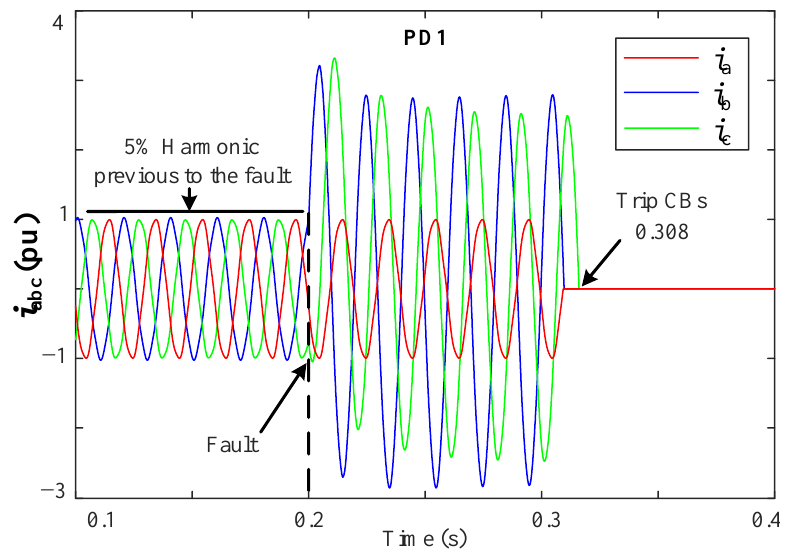
Figure 12. i abc currents during a 2PH-G fault at Zone1, phases b and c to Figure 12. 𝑖 𝑎𝑏𝑐 currents during a 2PH-G fault at Zone1, phases b and c to ground.